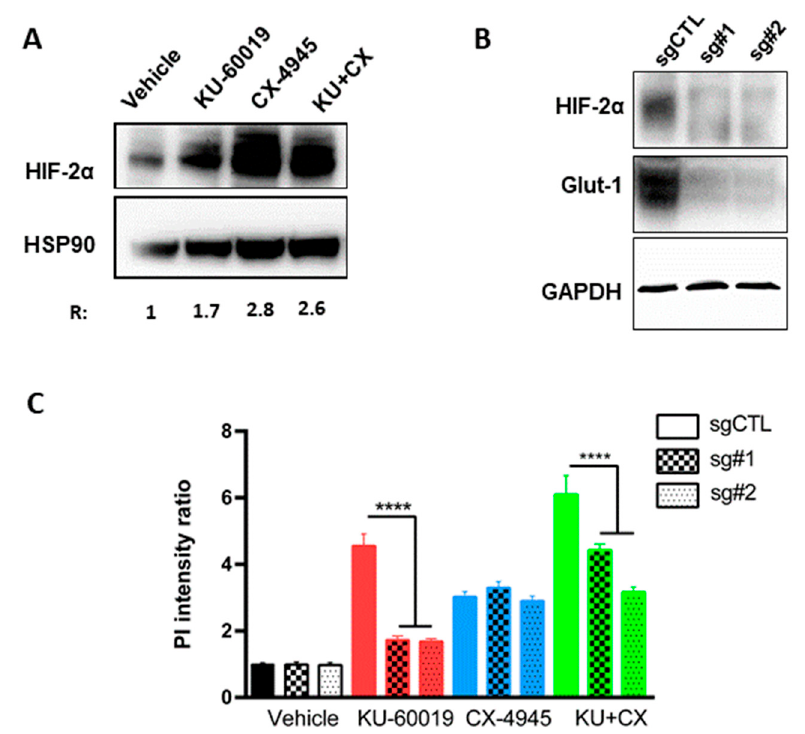
Figure 4. HIF-2 α expression enhances vulnerability to the CX-4945/KU-60019 combination. ( A ) 786- O VHL null MCTS were treated either with vehicle (DMSO), KU-60019 (10 µ M) and/or CX-4945 (5 µ M) for 48 h. Western blot analysis shows protein expression levels of HIF-2 α and HSP90 as loading control. ( B ) Protein extracts from HIF2- α CRISPR/CAS9 (sg#1 and sg#2) and CTL CRISPR/cas9 (sgCTL) 786-O cells culture in 2D were analyzed by Western blot. Shown are expression levels of HIF2- α , Glut-1 and GAPDH as a loading control. ( C ) MCTS, as described in ( B ), were treated either with vehicle (DMSO), KU-60019 (10 µ M) and/or CX-4945 (5 µ M) for 48 h. Cell death was